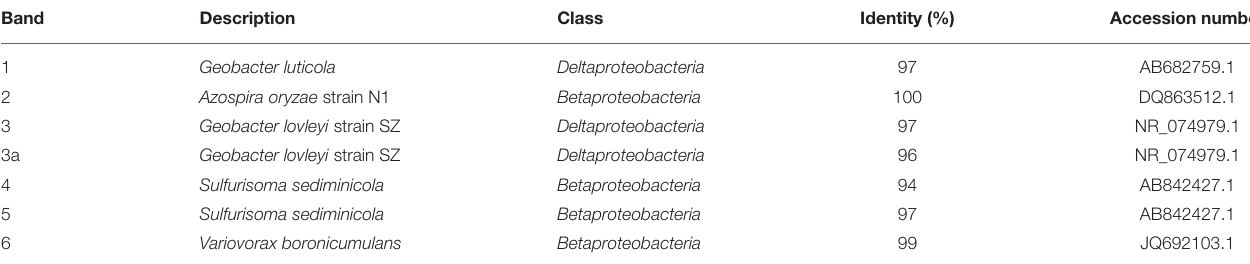
TABLE 5 | BLASTn results’ best alignments for the different band sequences (Figure 3).